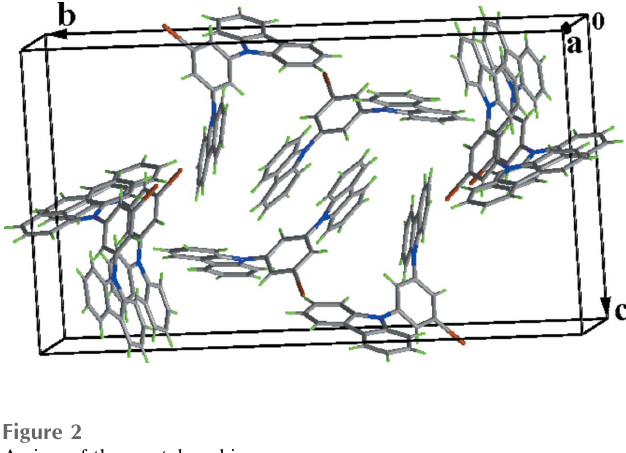
Figure 2 A view of the crystal